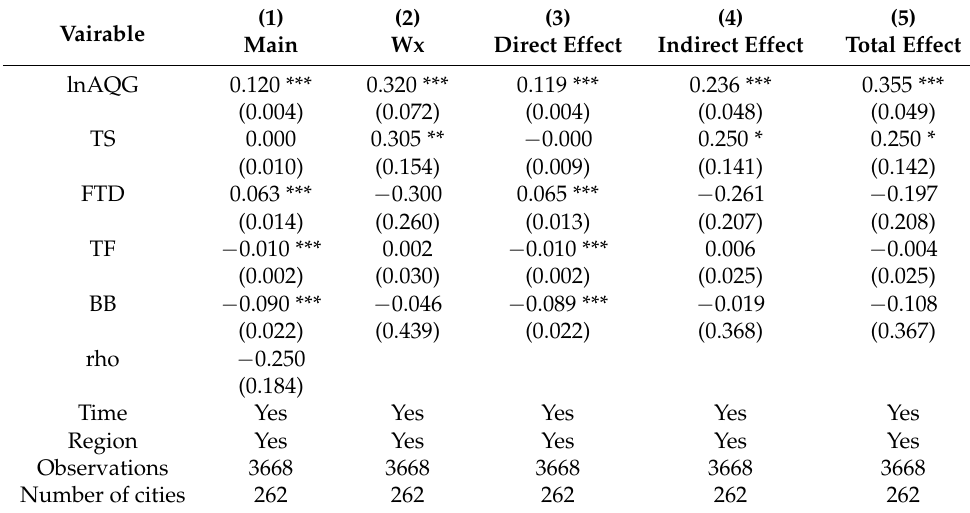
Table 13. Weight matrix of economic